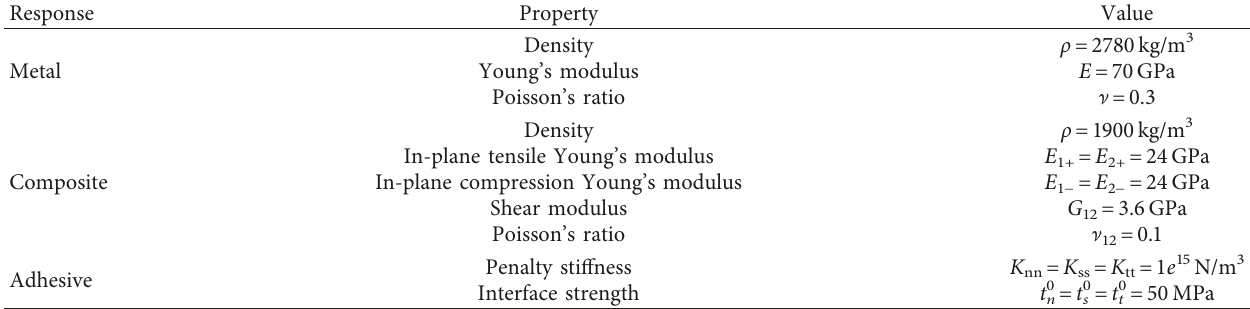
Table 1: Material properties used in the FE model.